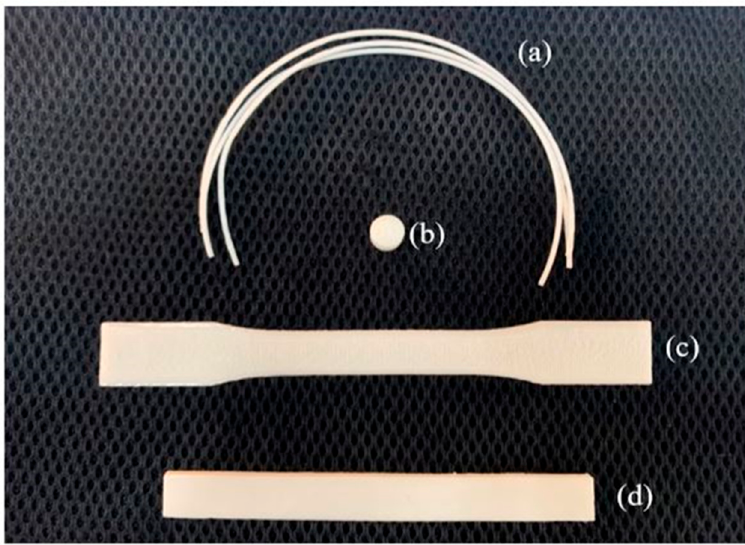
Figure 8. Filaments and specimens for mechanical testing, ( a ) filaments for tensile testing; ( b ) specimen for compression testing; ( c ) specimen for tensile testing; and ( d ) specimen for flexural testing.